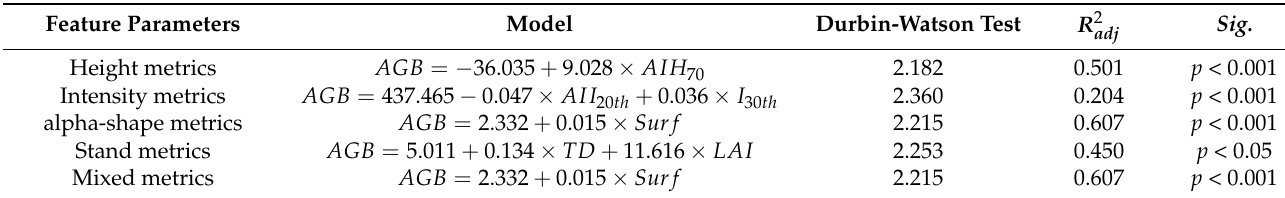
Table 8. Different linear regression